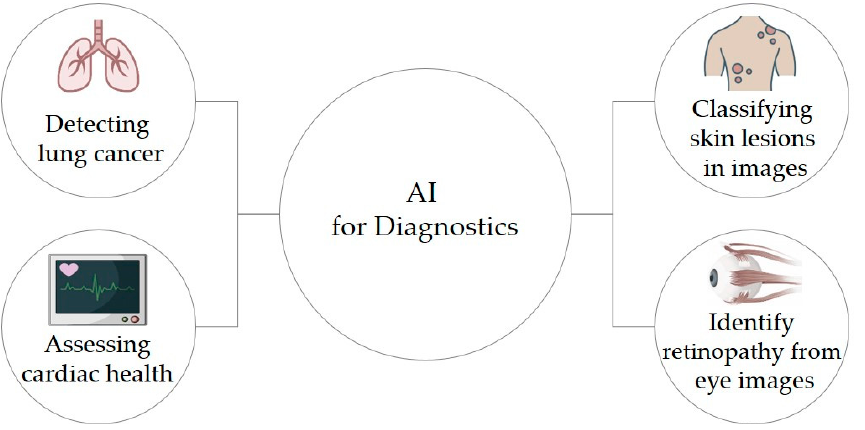
Figure 2. Artificial intelligence (AI) for diagnostics.